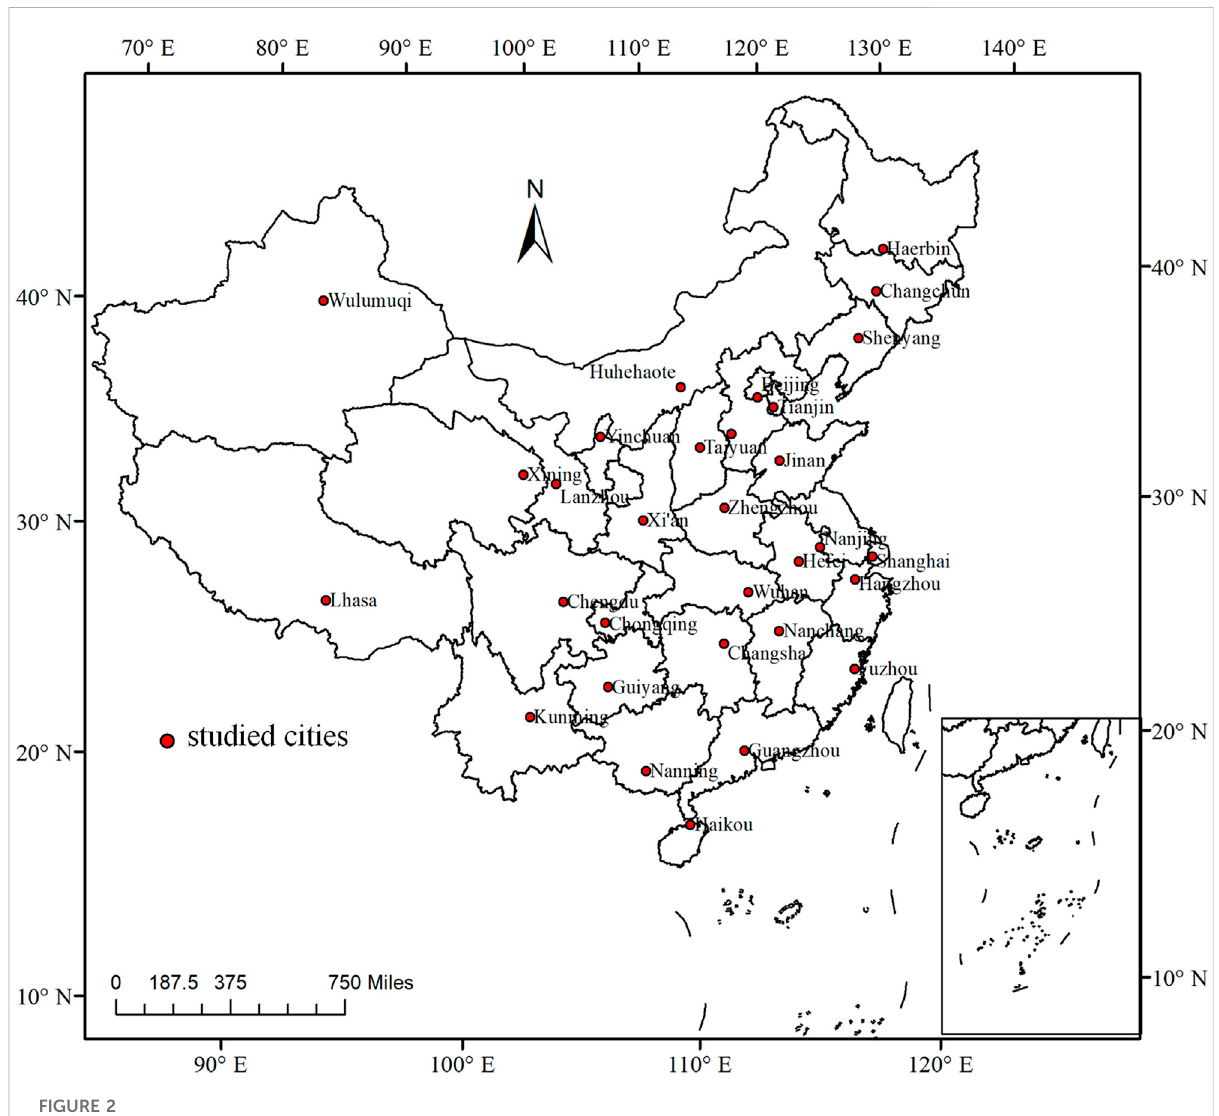
FIGURE 2 Geographic locations of 31 studied cities in